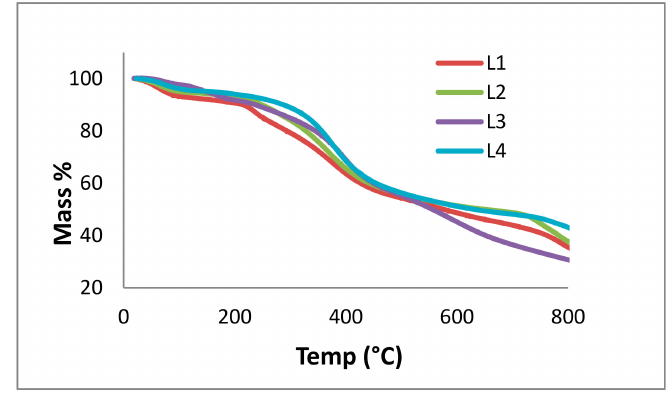
Figure 9. Thermogravimetric analysis (TGA) curves for kraft lignin purification fractions: L1 (red), L2 (green), L3 (purple), and L4 (blue), measured from 0 to 800 ◦